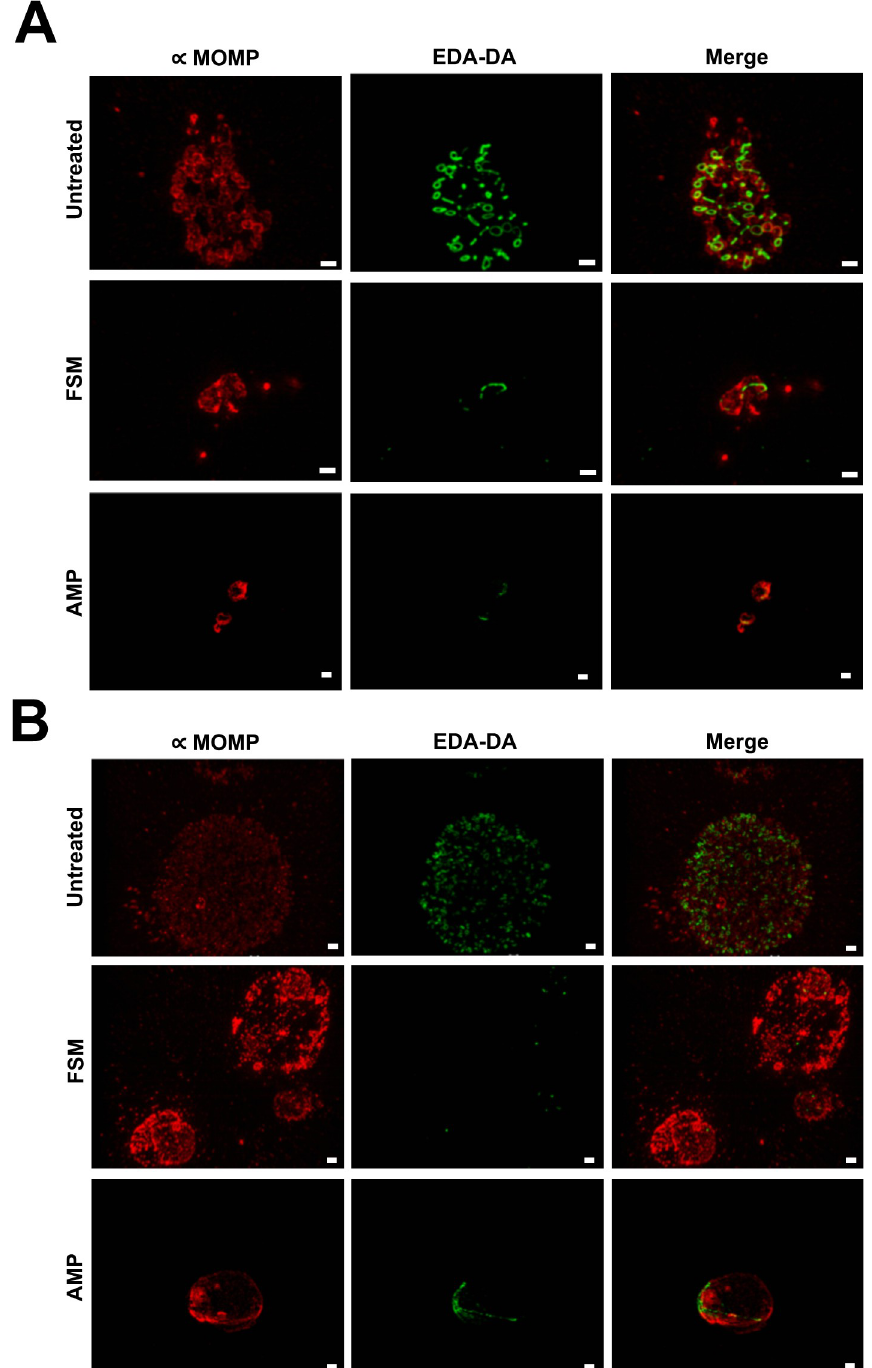
Fig 7. Structured illumination microscopy of D-amino acid dipeptide (DAAD) peptidoglycan labeling in FSM- treated C . trachomatis . Structured illumination microscopy was conducted on untreated, FSM-treated, or AMP- treated C . trachomatis- infected HeLa cells. 1 mM EDA-DA and either 1 μ g/mL AMP or 2.44 mM FSM were added at T0 and coverslips were fixed at 14 h (A) or 38 h (B) post chlamydial infection. Peptidoglycan labeling (represented by EDA—DA) is shown in green and the C . trachomatis major outer membrane protein (MOMP) is shown in red. Images are representative of ~20 inclusions viewed per condition. Scale bars = 1 μ m.